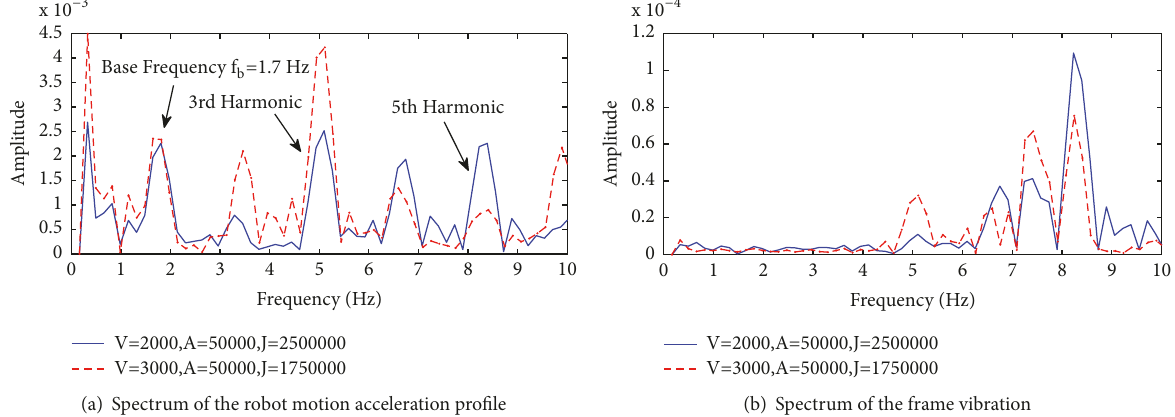
Figure 16: Comparative results of two cases with same cycle time 𝑇 = 0.65 s. However, the frame vibration amplitudes have significant difference: 0.7353 m/s 2 and 1.2286 m/s 2